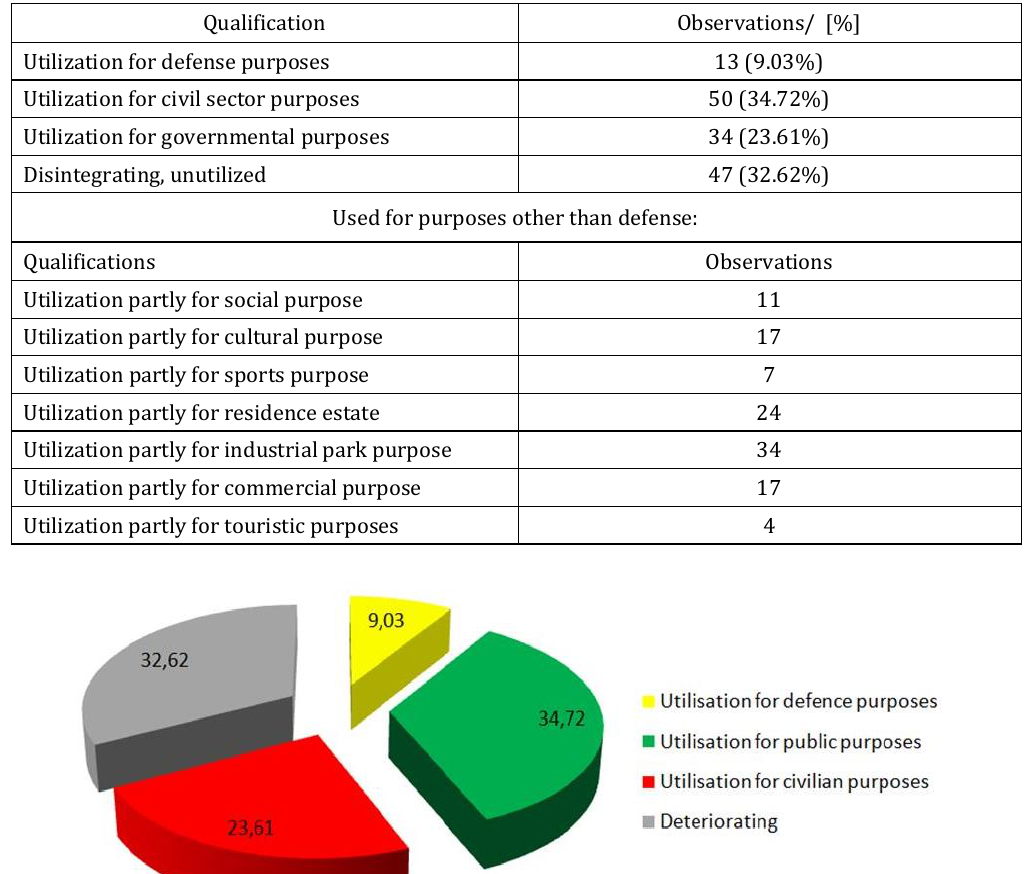
Table 1. Currently utilized barrack, utilization types in more detail (Source: author’s research, 2022)